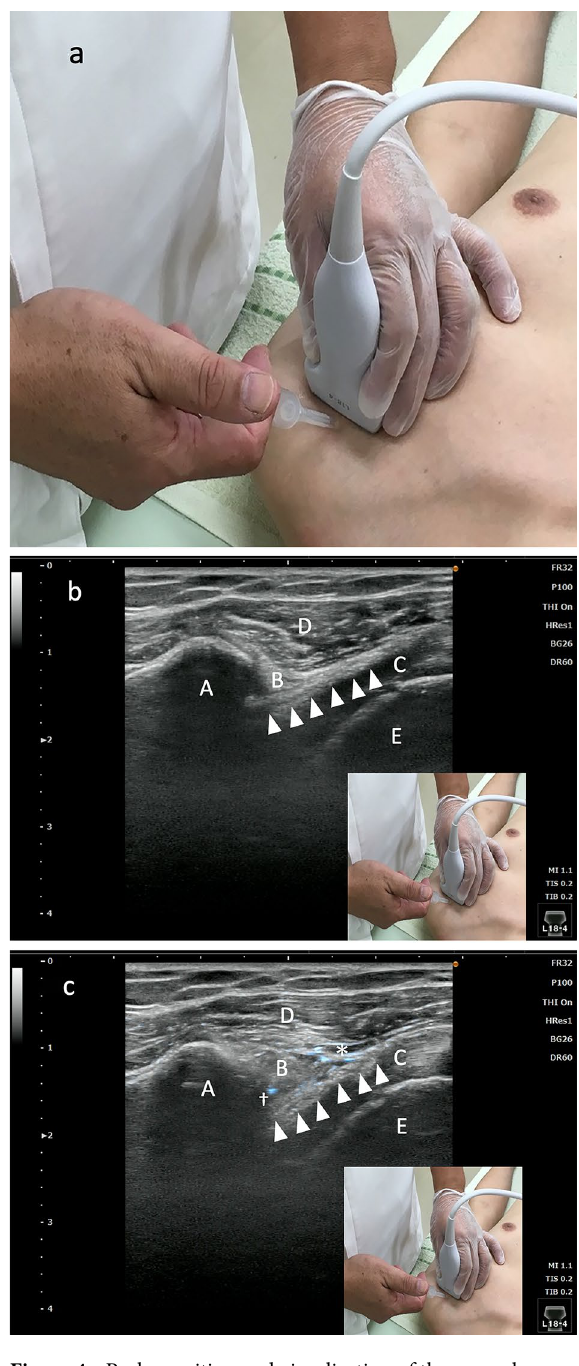
Figure 4. Probe position and visualization of the coracohumeral ligament (CHL). ( a ) Probe positions during ultrasound-guided fascia hydrorelease of the CHL. The patient was placed in a supine position, and the affected shoulder was maximally externally rotated within the patient’s tolerance. An ultrasound probe was placed on the upper lateral side of the shoulder. ( b ) Visualization of the coracohumeral ligament (CHL). The CHL was visualized with the probe placed at the position shown in ( a ). A, coracoid process; B, peribursal fat around subacromial bursa; C, subscapularis tendon; D, deltoid muscle; E, humeral head; arrowheads, CHL. ( c ) Ultrasound image of ultrasound-guided fascia hydrorelease (US-FHR) on the coracohumeral ligament (CHL). Two ml of normal saline was injected within the CHL. The needle tip (dagger) was always visualized and the position of the needle tip was controlled to remain on the CHL throughout the injection. The CHL becomes irregularly edematous after the US-FHR and the irregularity disappears after a certain period (depending on the subjects). A, coracoid process; B, peribursal fat around subacromial bursa; C, subscapularis tendon; D, deltoid muscle; E, humeral head; arrowhead, CHL, asterisk: fluid collection. Note: the CHL bundle was released into group of thin strip-shaped lines (the whole procedure can be viewed in Supplementary Video